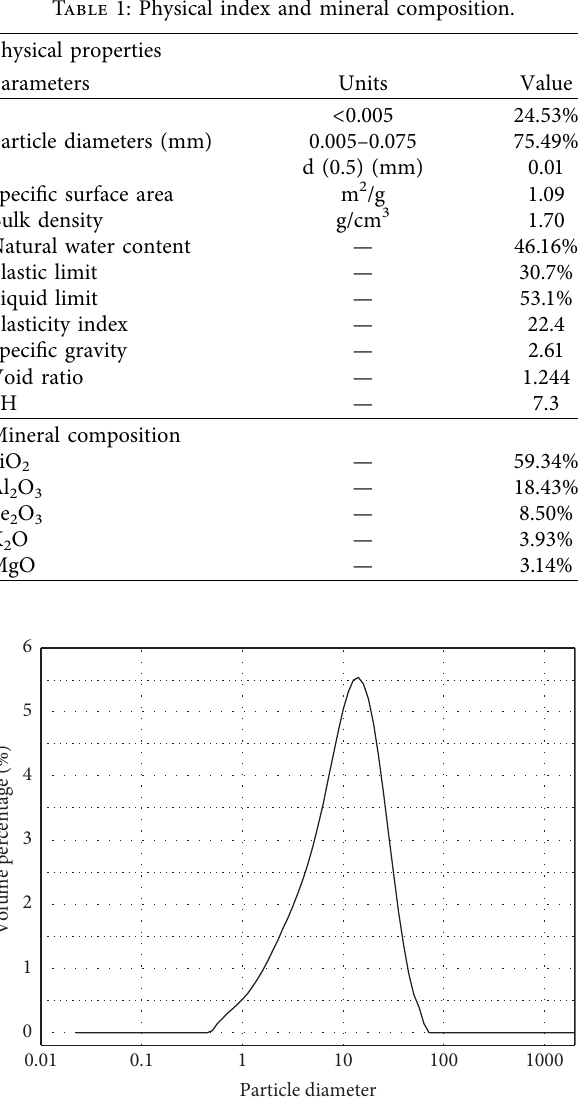
Figure 1: Particle size